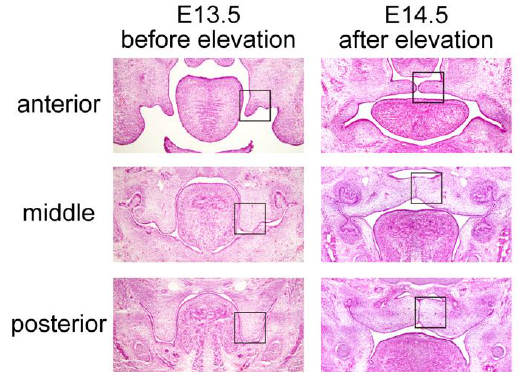
Figure 1. Hematoxylin- and eosin-stained coronal sections of the developing palatal shelves. Histo- logical changes before (E13.5) and after (E14.5) palatal elevation. Coronal planes along the anterior– posterior axis in embryos: anterior (anterior to molar tooth bud), middle (same plane as molar tooth bud), and posterior (posterior to molar tooth bud). The boxed areas show the corresponding areas at higher magnification in Figures 2 and 3. Scale bar: 500 µ